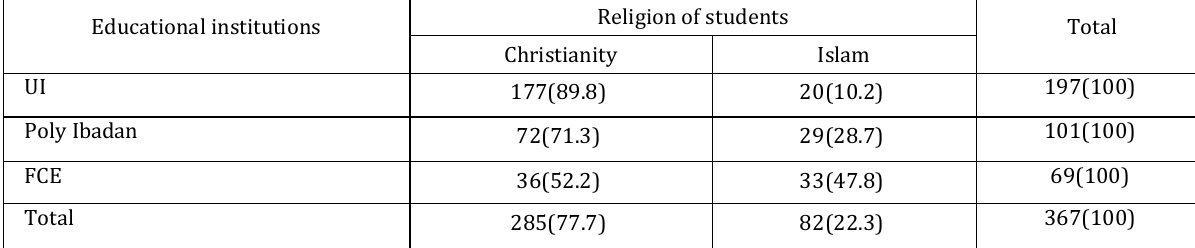
Table 4. Religion of students (source: Authors’ fieldwork data analysis, 2016)